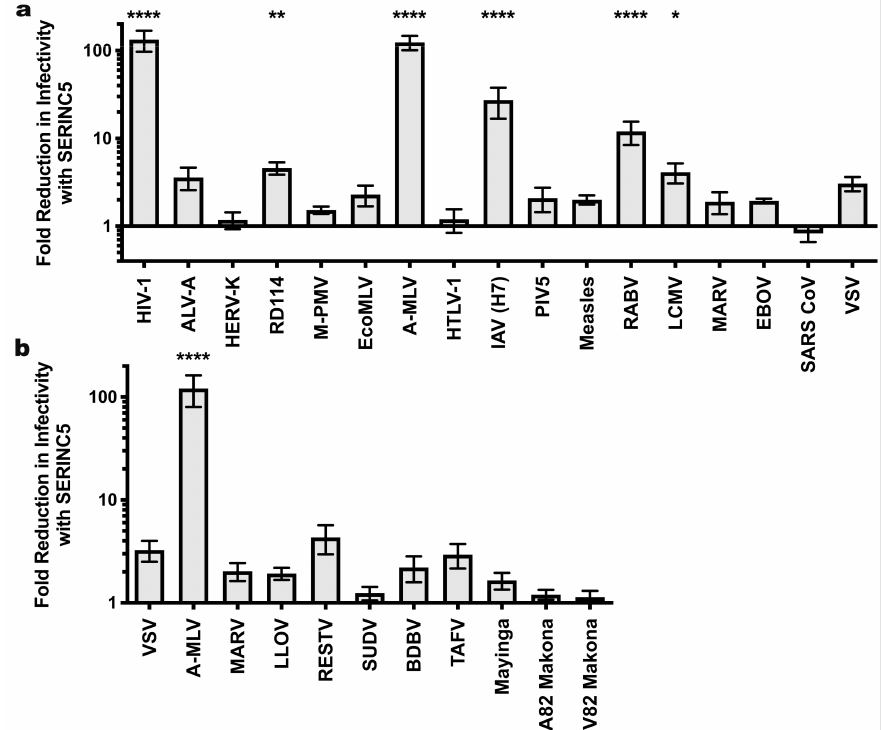
Figure 1. Sensitivity of HIV-1 pseudotypes to SERINC5 antiviral activity. ( a ) Effect of SERINC5 on transduction efficiency by HIV-1 cores pseudotyped with a diverse panel of viral glycoproteins. Transductions used HEK293 cells as target cells except that HIV-1 pseudotypes used TZMbl cells. HEK293 cell targets were transfected with the cognate viral receptor prior to transduction with ecotropic MLV or avian leukosis virus A pseudotypes. ( b ) Sensitivity of filoviral glycoprotein pseudoviruses to SERINC5. Plotted is the difference in infectivity between viruses produced in the absence versus the presence of SERINC5. Each condition shows results of vector production from at least three independent transfections. Statistical significance of observed SERINC5 effects was determined via one-way ANOVA with Dunnett’s multiple comparisons post-test as indicated in the Materials and Methods. *, p < 0.05; **, p < 0.01; ****, p < 0.0001. HIV-1: human immunodeficiency virus-1; ALV-A: avian leukosis virus A; HERV-K: human endogenous retrovirus K; RD114: feline endogenous retrovirus RD114; M-PMV: Mason-Pfizer monkey virus; EcoMLV: ecotropic MLV; AMLV: amphotropic MLV; HTLV-1: human T cell lymphotropic virus type 1; IAV: influenza A virus; PIV5: parainfluenza virus 5; RABV: rabies virus; LCMV: lymphocytic choriomeningitis virus; MARV: Marburg virus; EBOV: Mayinga isolate of Zaire Ebolavirus; SARS CoV: severe acute respiratory syndrome coronavirus; VSV: vesicular stomatitis virus; LLOV: Lloviu virus; RESTV: Reston virus; SUDV: Sudan virus; BDBV: Bundibugyo virus; TAFV: Taï Forest virus; Mayinga: Mayinga isolate of Ebola virus; Makona: Makona isolate of Ebola